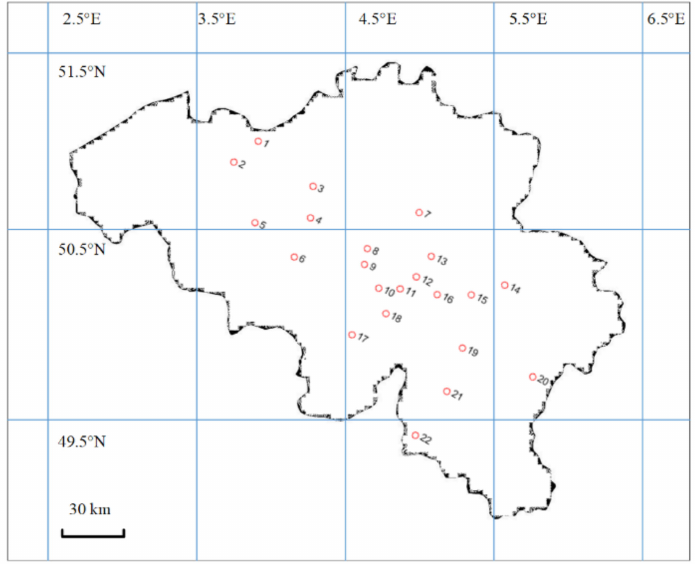
Figure 6. Schematic diagram of geographical distribution of photovoltaic (PV) power plants in